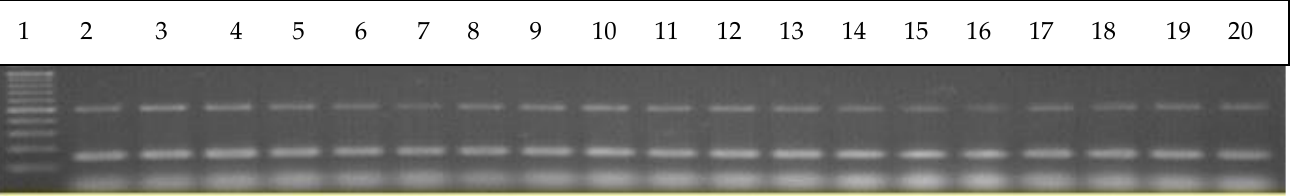
Figure 2. Multiplex PCR of ciaH and cia R genes (TCS CiaHR) for randomly selected clinical isolates. Size of the products: ciaH-529 bp, cia R-211 bp. 1, size standard; 2, positive control, S. mutans UA 159; 3 – 11, clinical isolates from adults; 12-20, isolates from children.